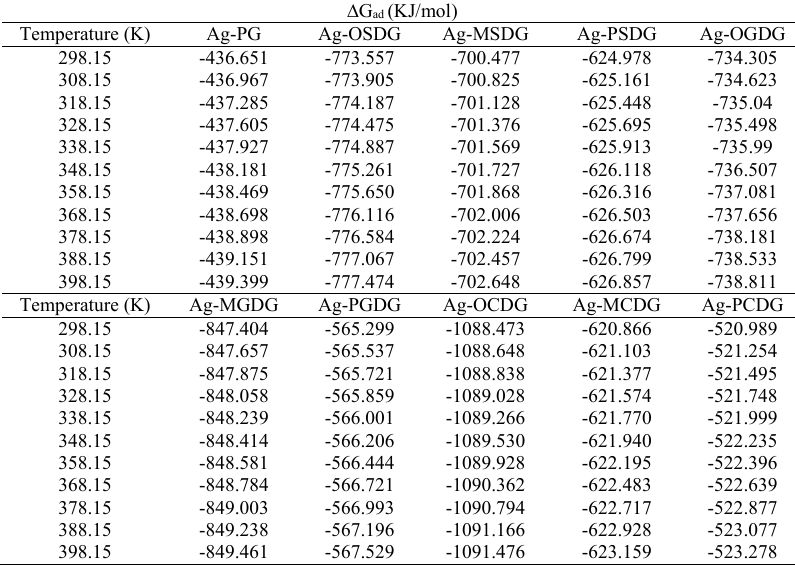
Table 3. Gibbs free energy changes values for the adsorption of silver (I) on the surface of ordinary and doped graphenes in the temperature range of 300-400 K.